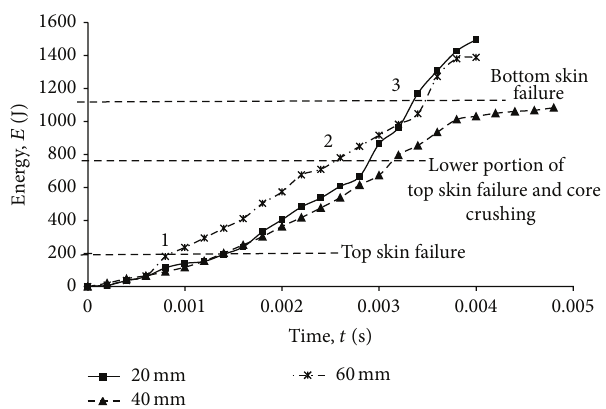
Figure 7: Energy profile diagram for the sandwich composite subjected to 15 J of impact energy.